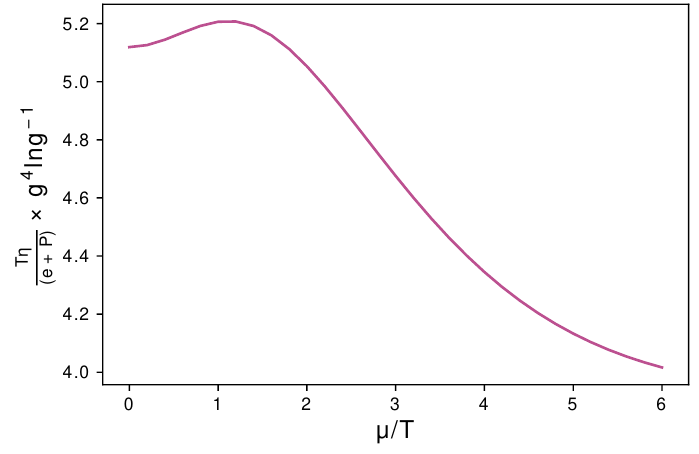
Figure 8 . Kinematic shear viscosity ηT/ ( e + P ) as a function of µ